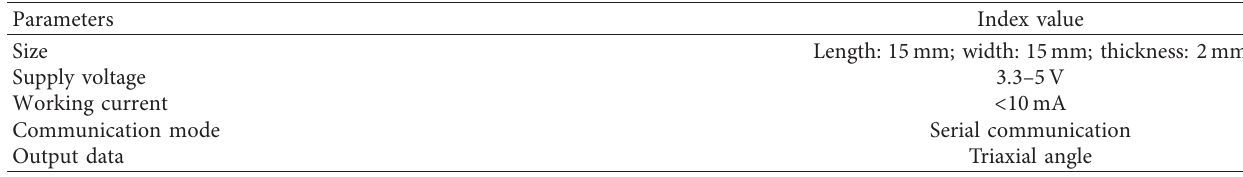
Table 1: Technical parameters of angular transducer module.